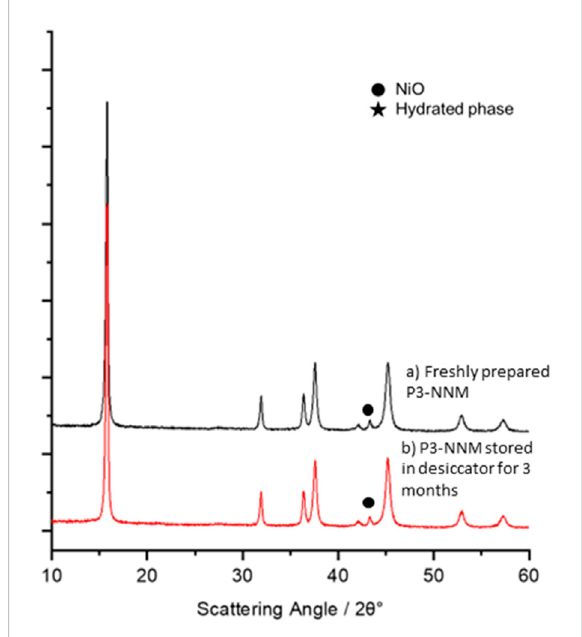
FIGURE 1 XRD data for P3-NNM (A) freshly prepared (black) and (B) after storage in a desiccator for 3 months (red). Secondary phases are indicated using a fi lled circle (NiO) or star (hydrated phase)